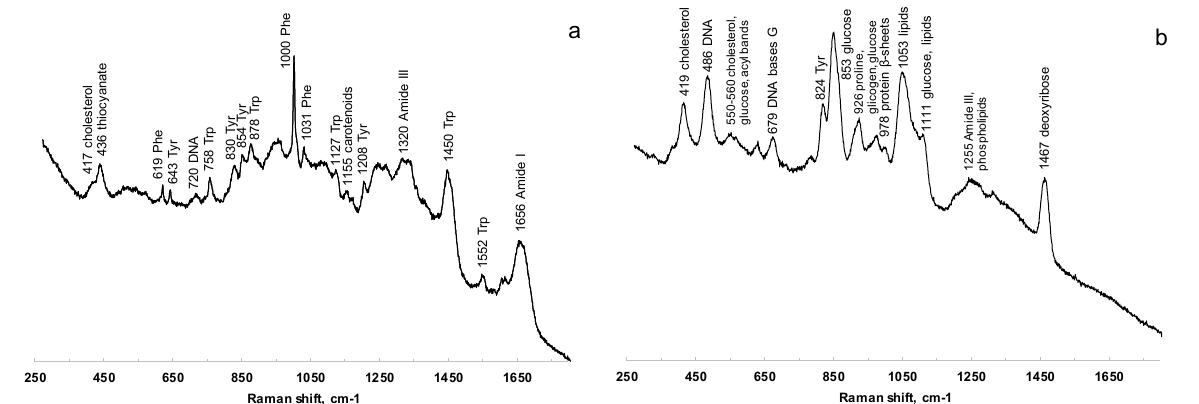
Figure 6. Comparison of Raman spectra at 785 nm of saliva before ( a ) and after ( b ) filtering with 3 kDa filters.